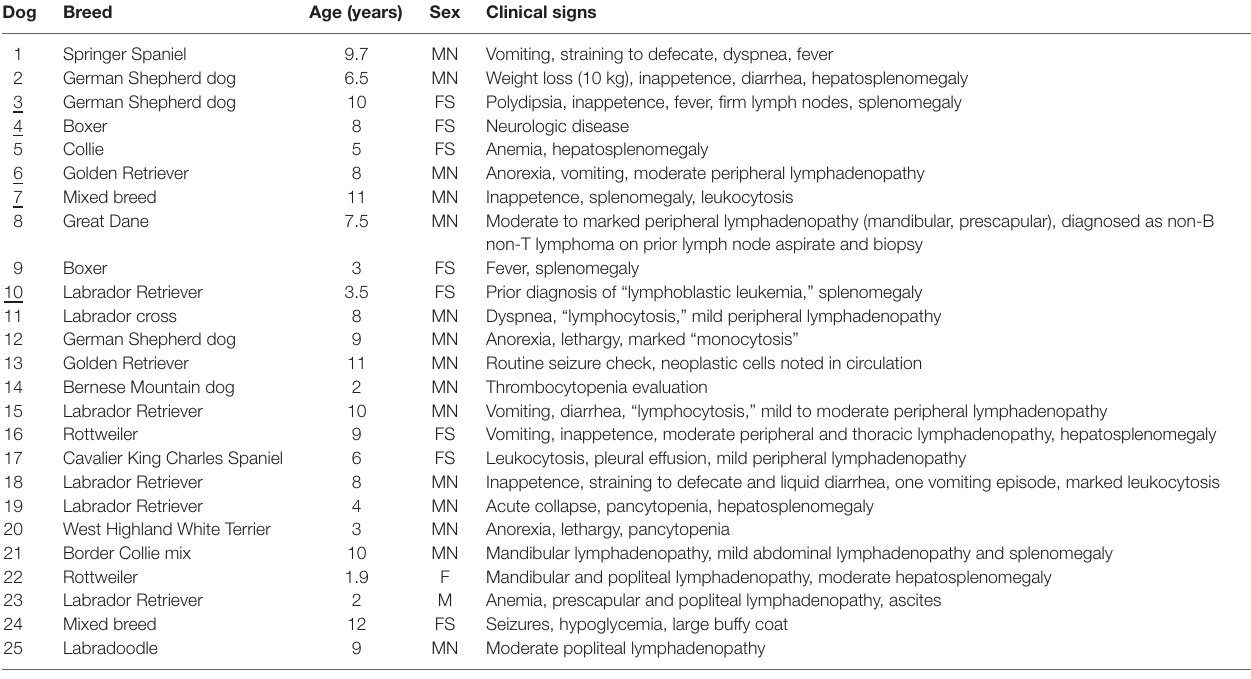
TaBle 4 | signalment and presenting clinical signs in 25 dogs with acute myeloid leukemia in which clonality testing was performed.